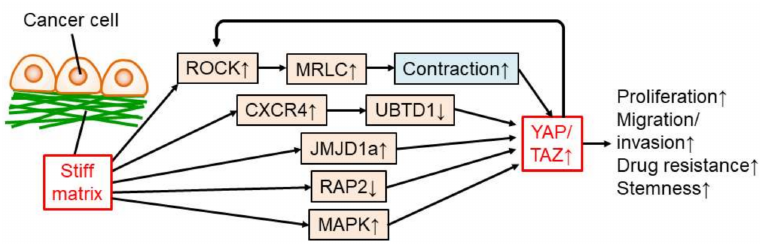
Figure 2. Regulation and function of YAP/TAZ in cancer cells modulated by a stiff matrix. ↑ : upregu- lation, ↓ :